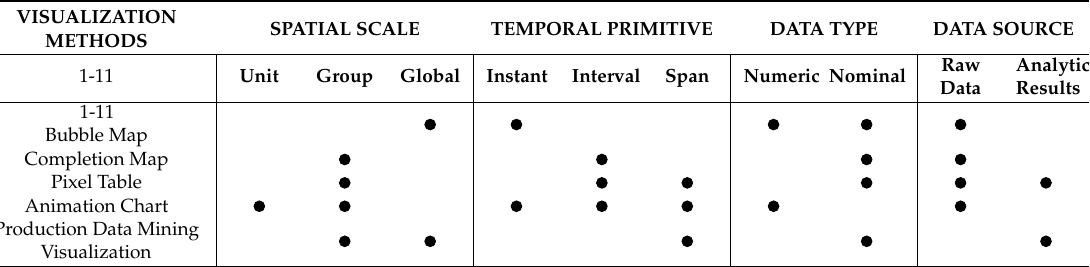
Table 1. Summary of visualization methods in OGVES.